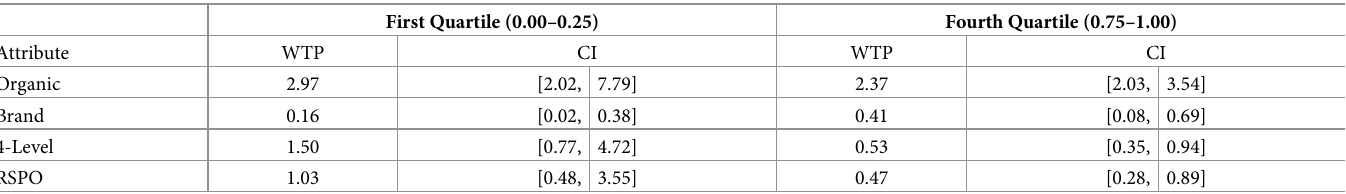
Table 7. Willingness-to-pay estimates first and fourth quartile of predicted LV, full sample.